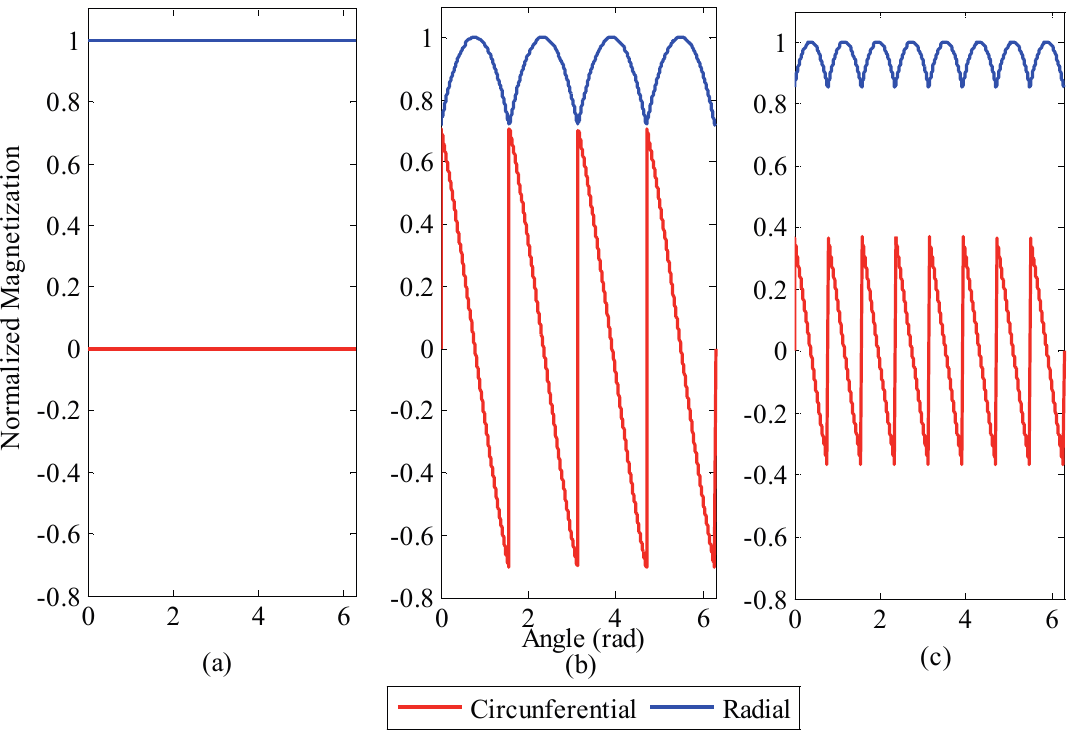
Figure 4. Normalized radial and circumferential magnetization components of ring-shaped magnets with ( a ) ideal radial magnetization, ( b ) four segments with parallel magnetization, and ( c ) eight segments with parallel